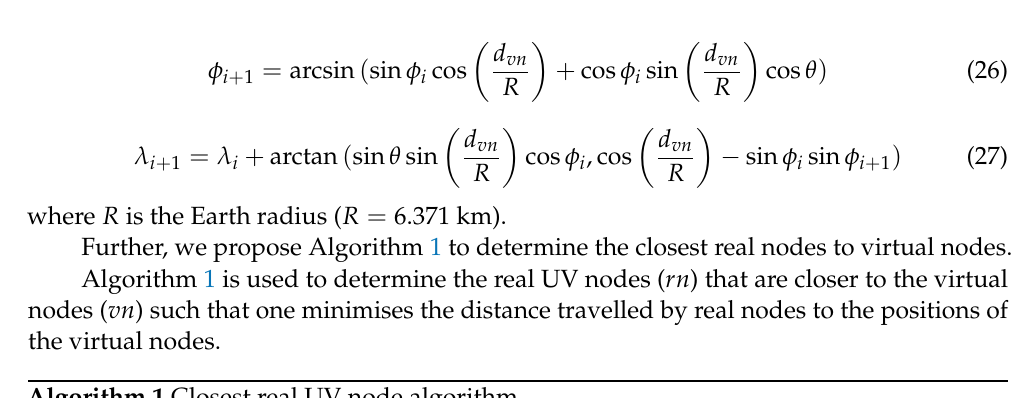
Algorithm 1 Closest real UV node